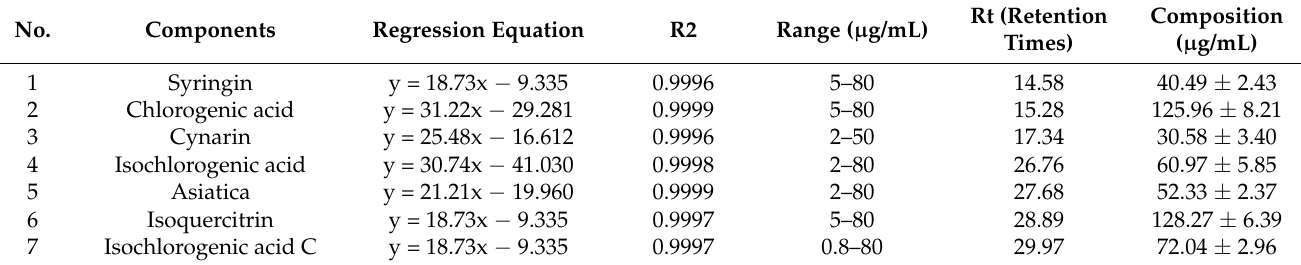
Table 1. Quantitative linear ranges, correlation coefficients (R 2 ), and quantitative analysis results of the standards.